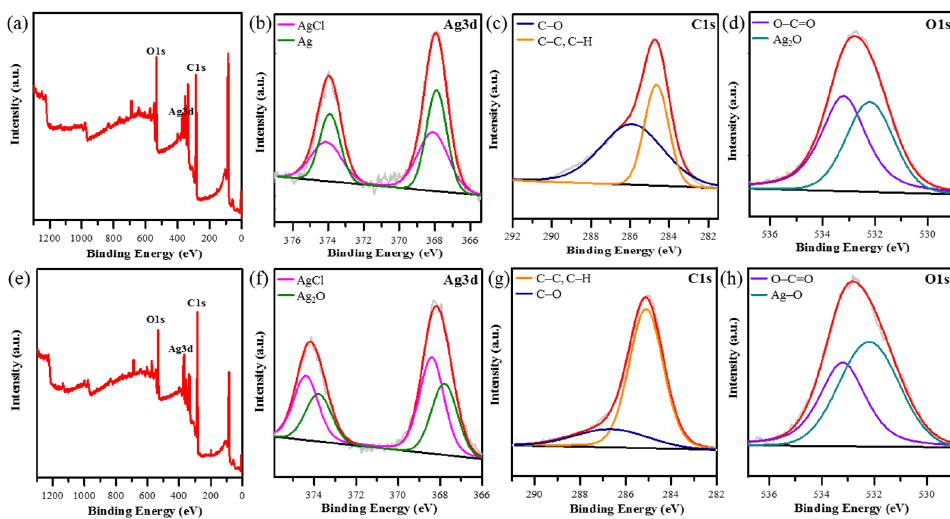
Figure 4. XPS spectra of the ( a , e ) survey, ( b , f ) Ag 3d, ( c , g ) C1s, and ( d , h ) O1s of A-the BG-AgNPs and E-BG-AgNPs, respectively.